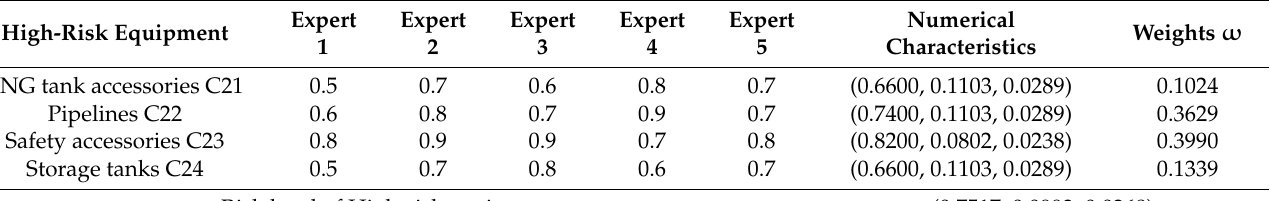
Table 7. Evaluation and numerical characteristics of “High-risk equipment”.